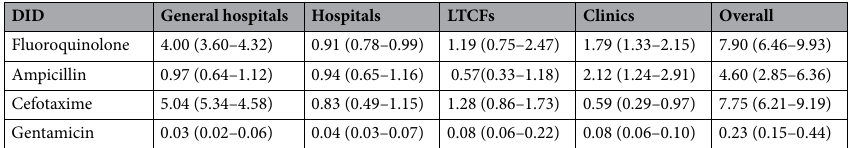
Table 1. Antibiotic prescription in South Korea between 2007 and 2018. Each value in the cell indicates the mean DID and the range (min–max). DID defined daily dose/1000 inhabitants/day, LTCFs long-term care facilities.